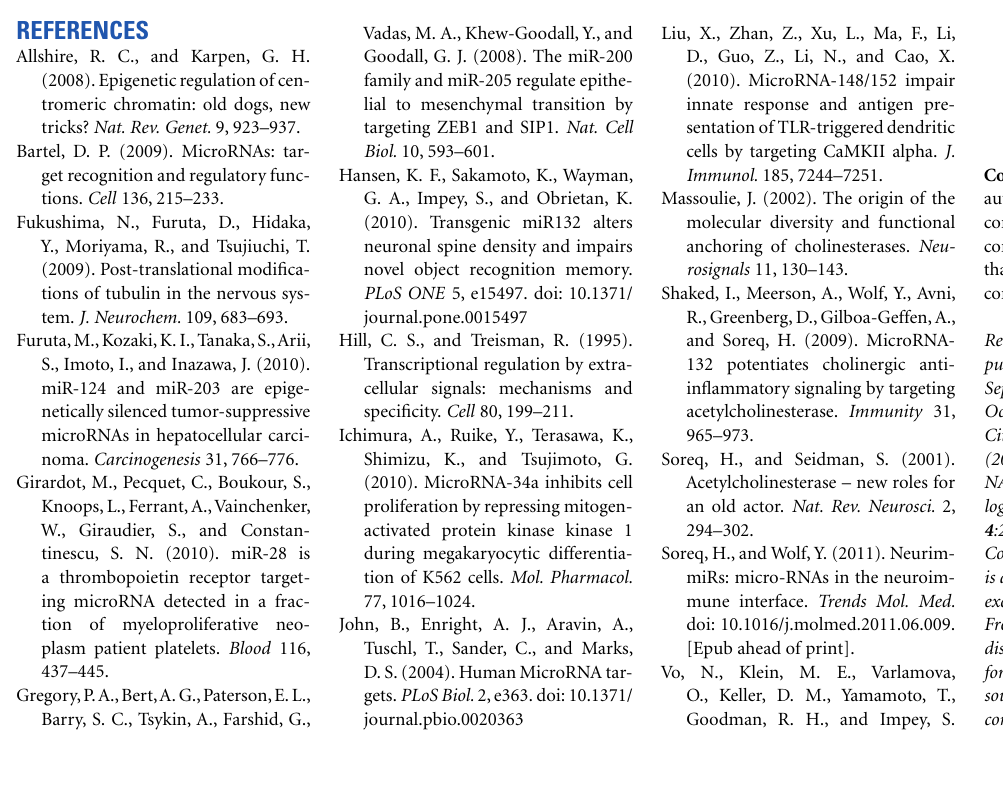
FIGURE 3 | MiR regulators of biological processes shared by cholinesterases and validated targets of these miRs. (A) miRs targeting transcripts participating in the AChE-S and AChE-R relevant response to wounding (yellow)and neuron development processes(blue) or both categories(green). (B) miRs targeting transcripts participating in the BChE-relevant response to glucocorticoid stimulus